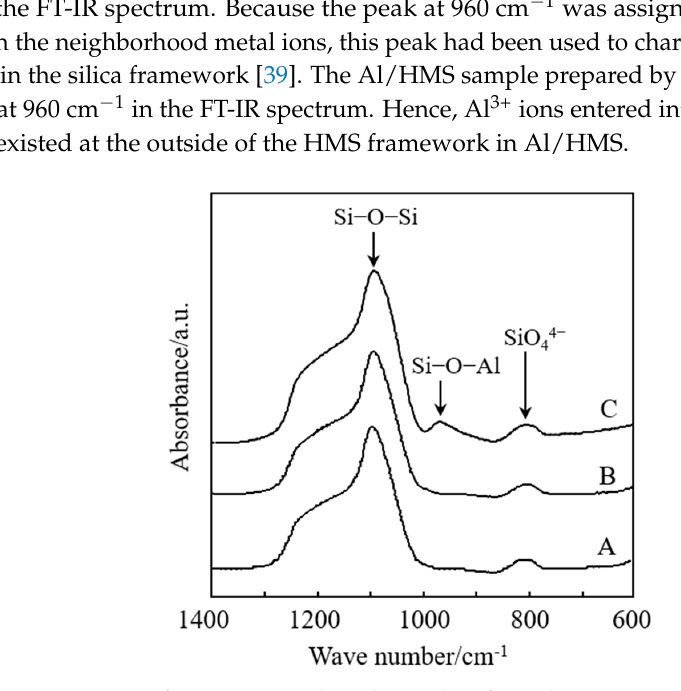
Figure 2. FT-IR spectra of various HMS-based samples after calcining at 550 °C for 4 h. ( A ): HMS; ( B ): Al/HMS; ( C ): Al-HMS.